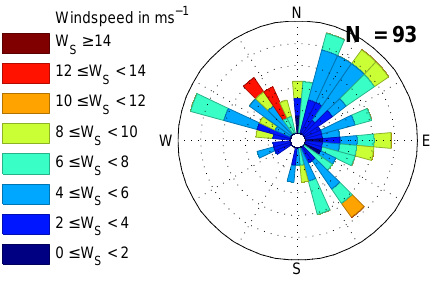
Figure 6. AMPS wind speed W s and direction for snowfall events identified in AMPS